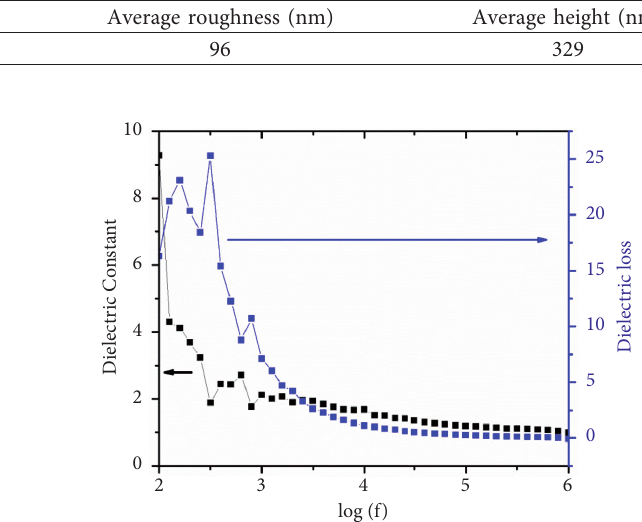
Figure 9: Dielectric constant and dielectric loss vs. log frequency of the V 2 O 5 thin film prepared at room temperature.